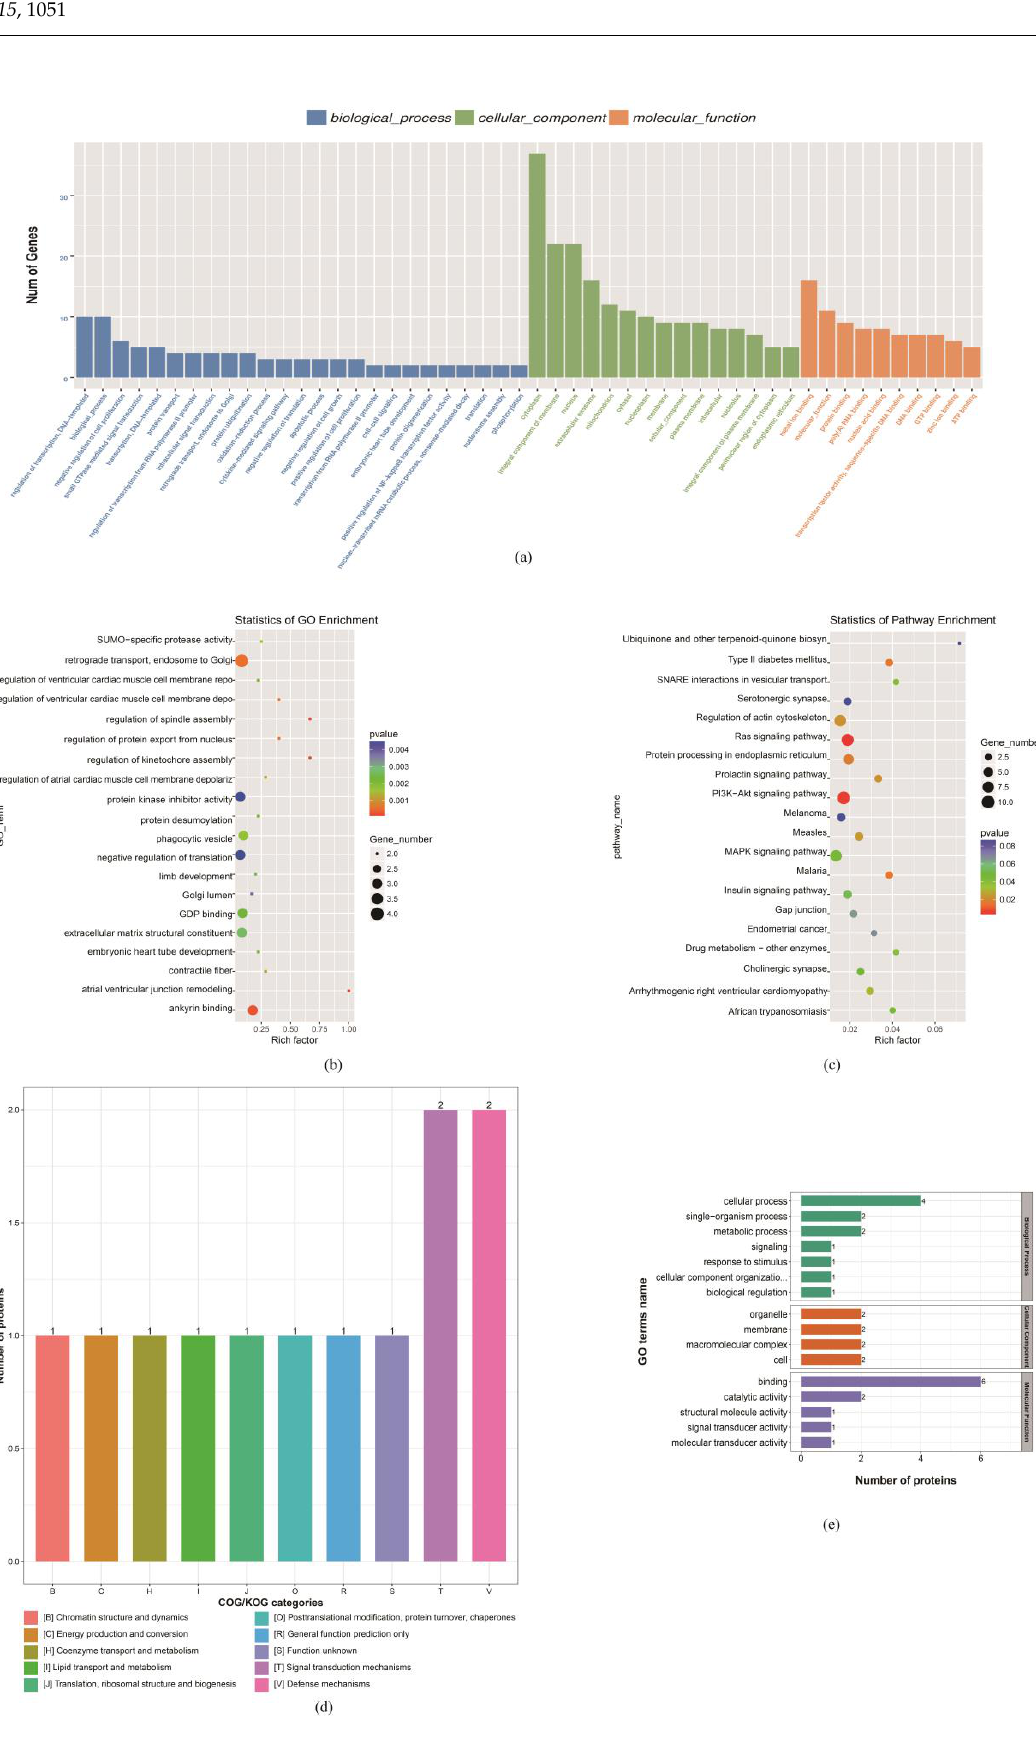
Figure 3. D85T vs. D85N differential expression mRNA and protein enrichment